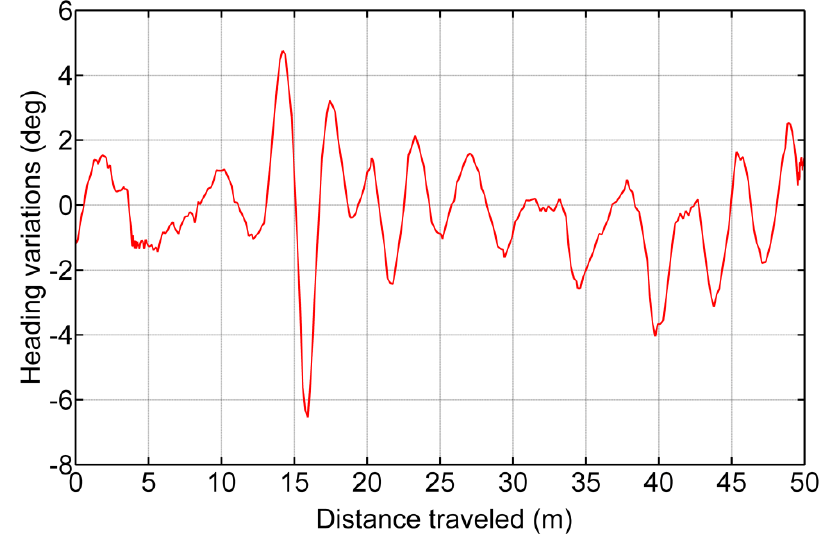
Figure 11. Example of heading variations with respect to the theoretical value when the vehicle is crossing the maize field.